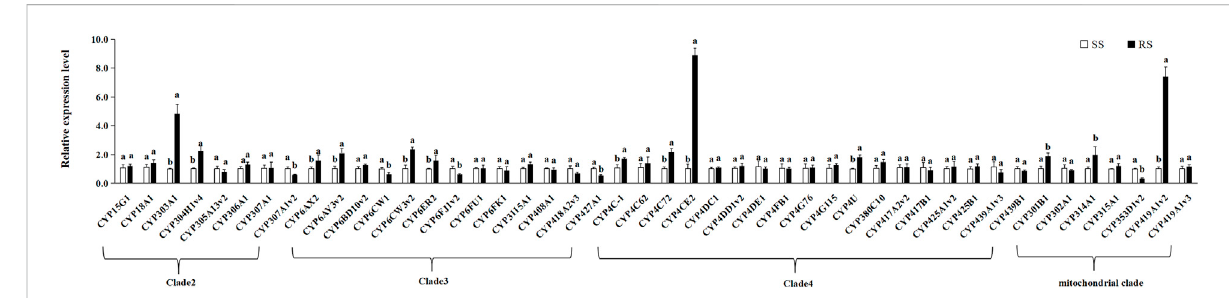
FIGURE 5 Means (±SE) of relative expression levels of P450 genes. Different letters above error bars for the same gene indicates signi fi cant differences between the RS and SS strains at 0.05 levels using the Tukey ’ s test.